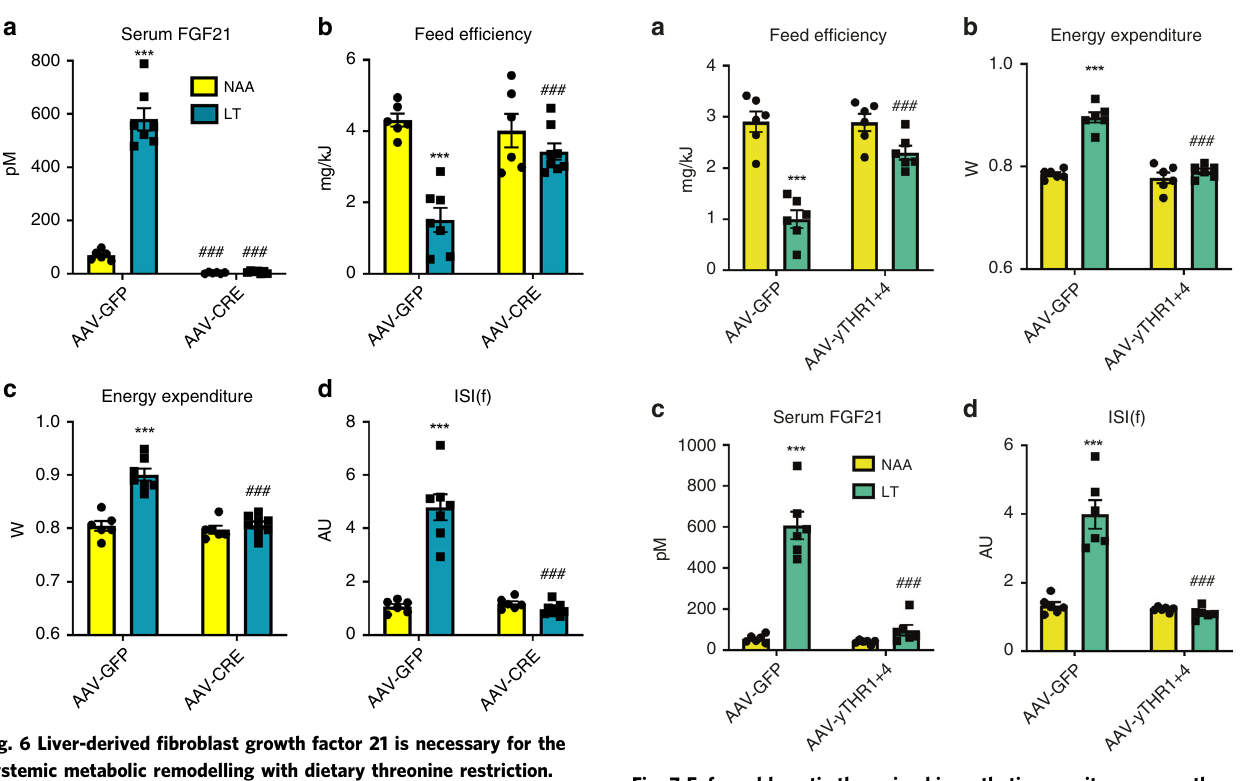
Fig. 7 Enforced hepatic threonine biosynthetic capacity reverses the systemic metabolic effects to dietary threonine restriction. a Feed ef fi ciency of mice in response to a 3-week treatment with diets containing 18% from amino acids (normal amino acid; NAA; yellow bars) and a diet with restricted amounts of threonine (LT; green bars), following prior treatments with adeno-associated viruses to transduce the liver to express yeast threonine biosynthetic enzymes (AAV-yTHR1 + THR4) or a negative control (AAV-GFP). Data are mean and SEM ( N = 6 individual mice per group). Data were analysed by two-way ANOVA with Holm – Sidak